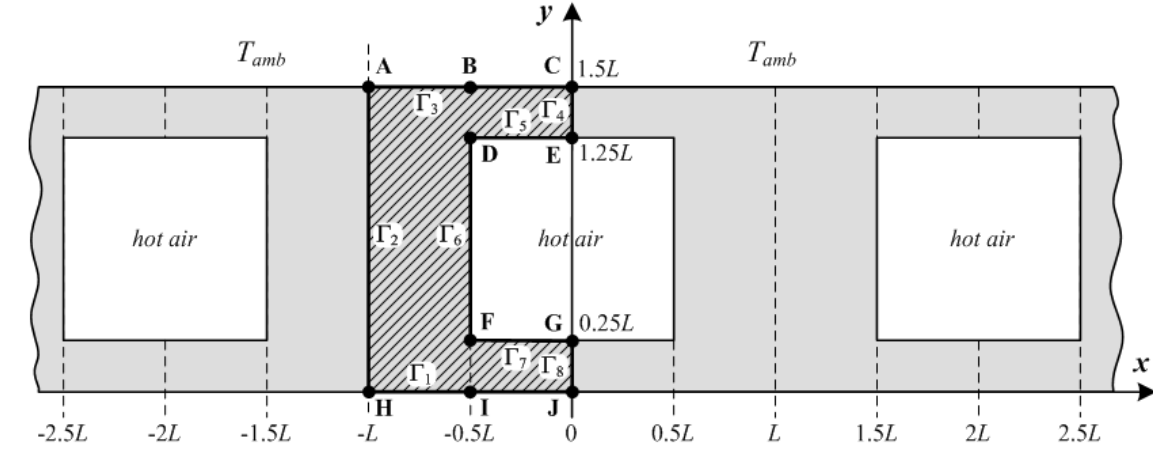
Figure 1: Cross-section of a floor heater with the analyzed fragment marked